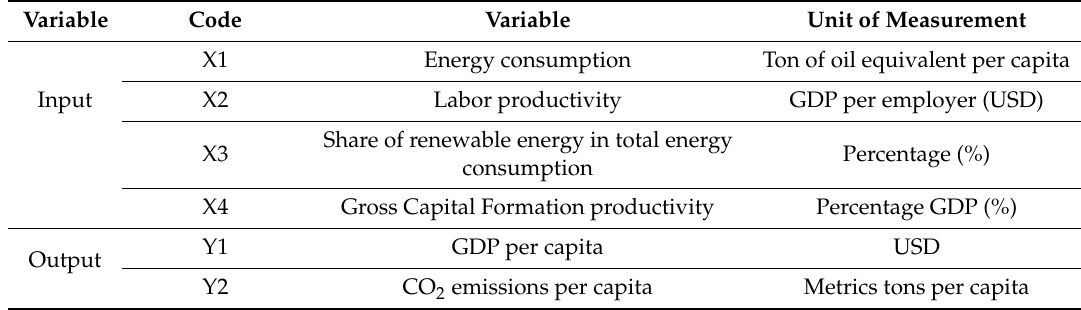
Table 3. Input and output variables and unit of